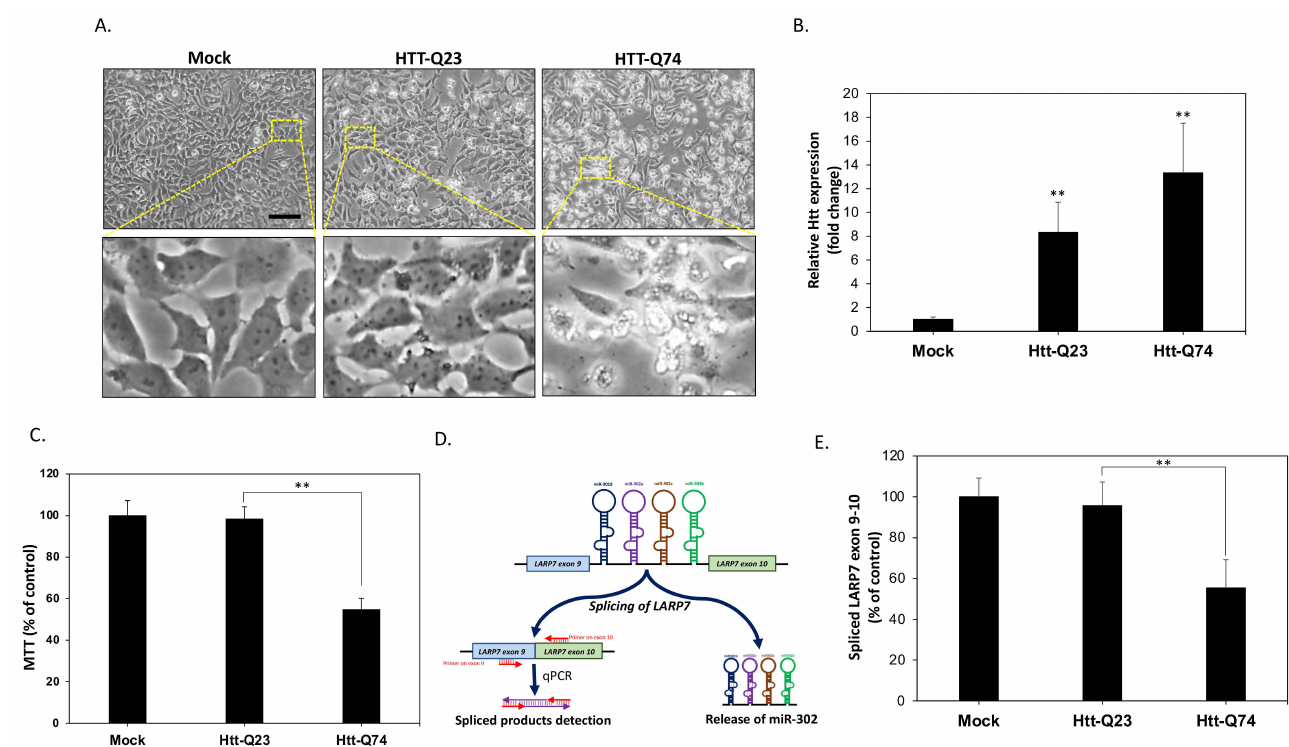
Figure 1. The generation of endogenous miR-302 is downregulated in mHtt-Q74-overexpressing neuronal cells. ( A ) Human SK-N-MC neuronal cells are transfected with the empty vector (mock), normal polyQ Htt (Htt-Q23), or polyQ-expanded mHtt (mHtt-Q74). Cell images are taken after 48 h of transfection, showing that no obvious morphological change of cytotoxicity is observed in both mock and Htt-Q23-transfected cells. However, cytotoxic features such as cell shrinkage are markedly increased in cells overexpressing mHtt-Q74. ( B ) The qPCR results show significantly increased mHtt mRNA levels, suggesting effective overexpression. ( C ) The MTT results indicate that after 48 h of transfection, cell viability is significantly reduced by approximately 55% in the mHtt-Q74-overexpressing group. ( D ) A proposed detection scheme demonstrates that the amount of intracellular miR-302 cluster can be obtained by indirectly measuring LARP7 exon 9–10 spliced products through a designed qPCR method. ( E ) The results of qPCR reveal that overexpression of mHtt-Q74 causes a significant decrease in exon 9–10 spliced products of LARP, suggesting the levels of miR-302 cluster are also suppressed. All values are presented as mean ± SEM. Significant difference was determined by using the multiple comparisons of Dunnett’s posthoc test for ** p < 0.01. Scale bar represents 50 µ